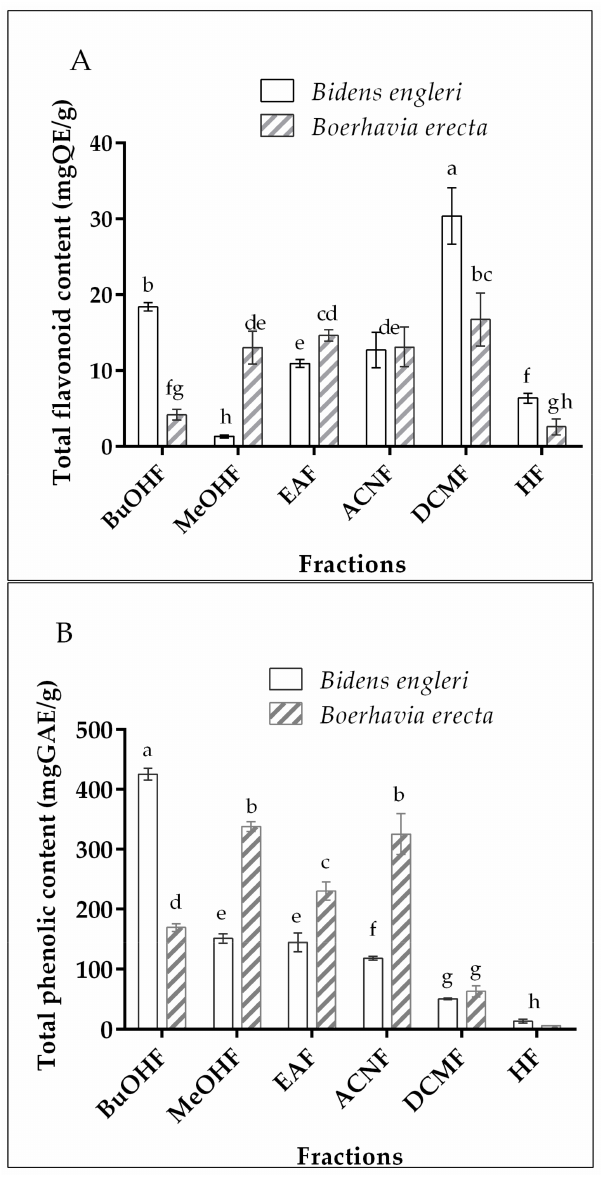
Figure 1. Polyphenolic content of fractions. A—total flavonoid contents; B—total phenolic contents. The data were obtained in two independent triplate tests ( n = 2 × 3). The data in each histogram were statistically different ( p < 0.05), except for the data with the same letters (a–h). BuOHF: butanol Fraction, MeOHF: methanol fraction, EAF: ethyl acetate fraction, ACNF: acetonitrile fraction, DCMF: dichloromethane fraction, HF: hexane fraction, mgQE/g: milligram quercetin equivalent per gram, mgGAE milligram gallic acid equivalent per